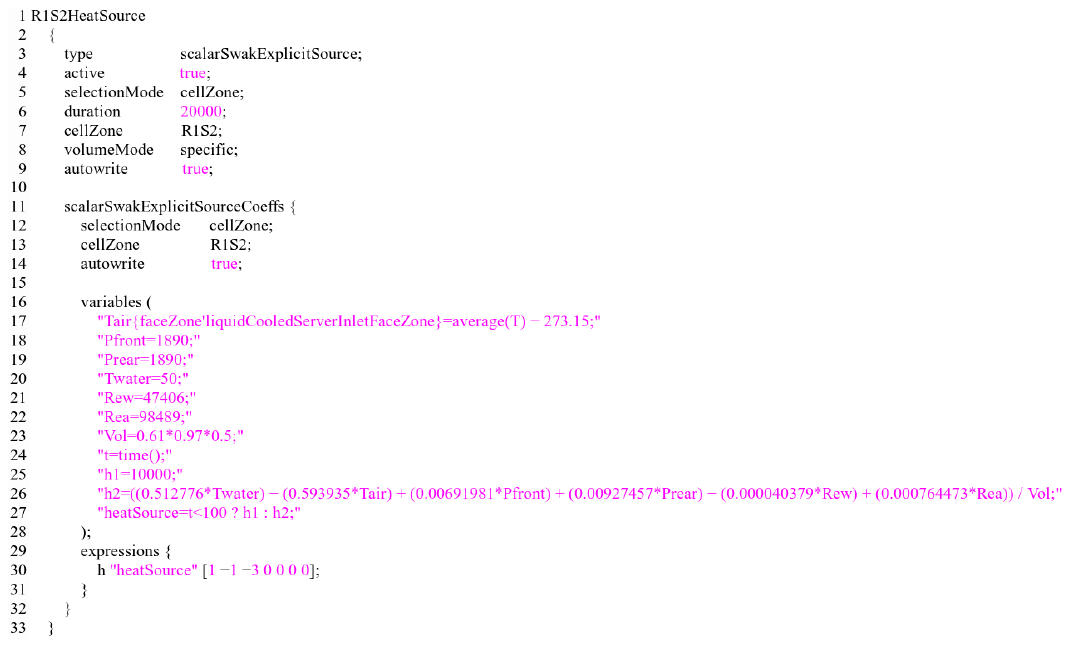
Figure 18. Implementation of the compact model to the liquid-cooled server. Purple color represents commands of the swah4foam.